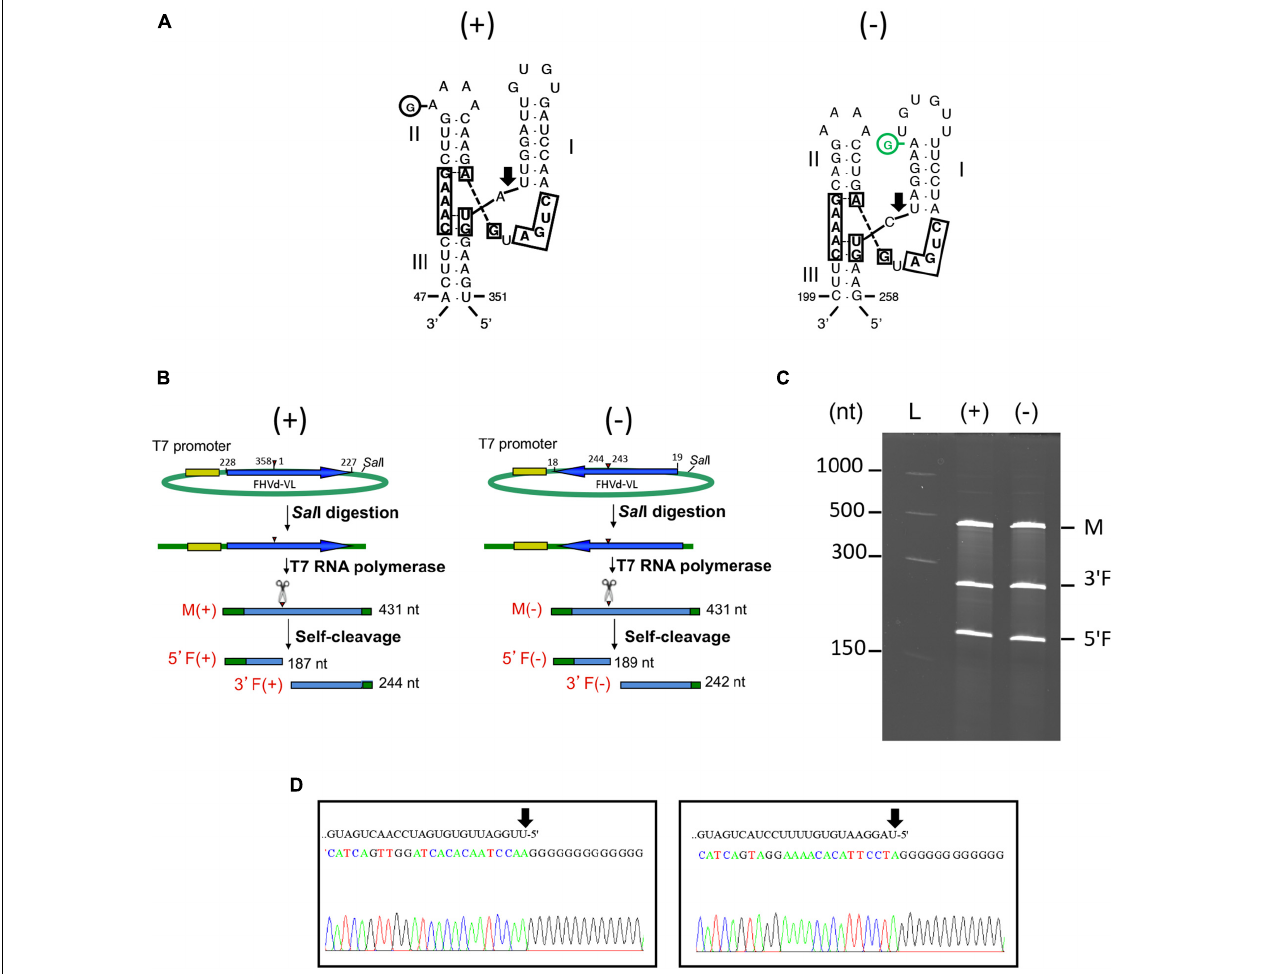
FIGURE 5 | (A) Primary and Y-shaped secondary structure of hammerhead ribozymes (HRzs) of ( + ) and ( − ) FHVd-LR are presented considering the existing X-ray crystallography data on this class of ribozymes (Pley et al., 1994). Stems I and II are closed by loops. The nucleotides of the catalytic core conserved in most natural hammerhead structures are boxed. The cleavage site of each ribozyme is indicated by an arrow. Nucleotides in the ( + ) and ( − ) polarity are numerated considering their positions in the variant FHVd-LR_A1 ( + ). Mutations are indicated in circles, with the compensatory mutation reported in green. (B) Schematic representation of the DNA templates and monomeric RNA products generated by in vitro transcription. Plasmids containing the monomeric sequence of FHVd-LR in opposite orientations were linearized with Sal I and transcribed with T7 RNA polymerase to produce monomeric transcripts (M) of opposite polarity and the respective 5 (cid:48) and 3 (cid:48) fragments (5 (cid:48) F and 3 (cid:48) F, respectively) derived from the HRz self-cleaving activity. In green, plasmid sequences; in yellow, polymerase promoter; in blue, FHVd-LR sequence, with the arrows indicating the ( + ) orientation; arrowheads and scissors mark the position of the self-cleavage sites. Numbers on the right of each RNA fragment indicate its expected size. (C) Analyses by PAGE of the in vitro transcription of the plasmids containing ( + ) and ( − ) monomeric FHVd-LR cDNA. L, RNA ladder with sizes indicated on the left; see panel (B) for M, 3 (cid:48) F and 5 (cid:48) F abbreviations. (D) Determination of self-cleavage site by 5 (cid:48) RACE of 3 (cid:48) F fragment resulting from the HRz-mediated cleavage of FHVd-LR monomeric transcripts [generated as reported in panels (B,C) ]. Sequencing electropherograms of 5 (cid:48) RACE products of the ( + ) and ( − ) 3 (cid:48) F fragments are shown on the left and right, respectively, with the self-cleaved RNA sequence reported on the top and the 5 (cid:48) terminal nucleotide indicated by the